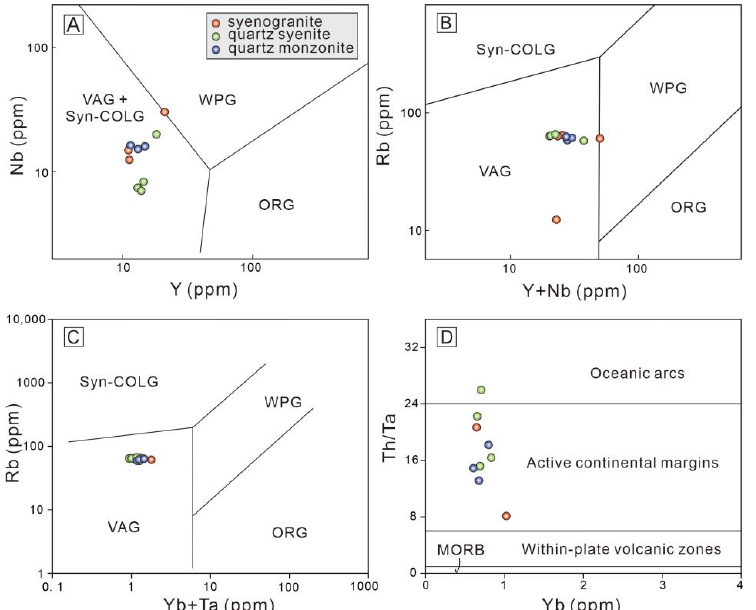
Figure 13. Tectonic implications discrimination diagrams ( A ) Nb vs. Y, ( B ) Rb vs. (Y + Nb) [70], ( C ) Rb vs. (Yb + Ta), ( D ) Th/Ta vs. Yb [48]. Abbreviations: VAG: Volcanic arc granites, Syn ‐ COLG: Syn ‐ collisional granites, WPG: Within plate granites, ORG: Ocean ridge granites.